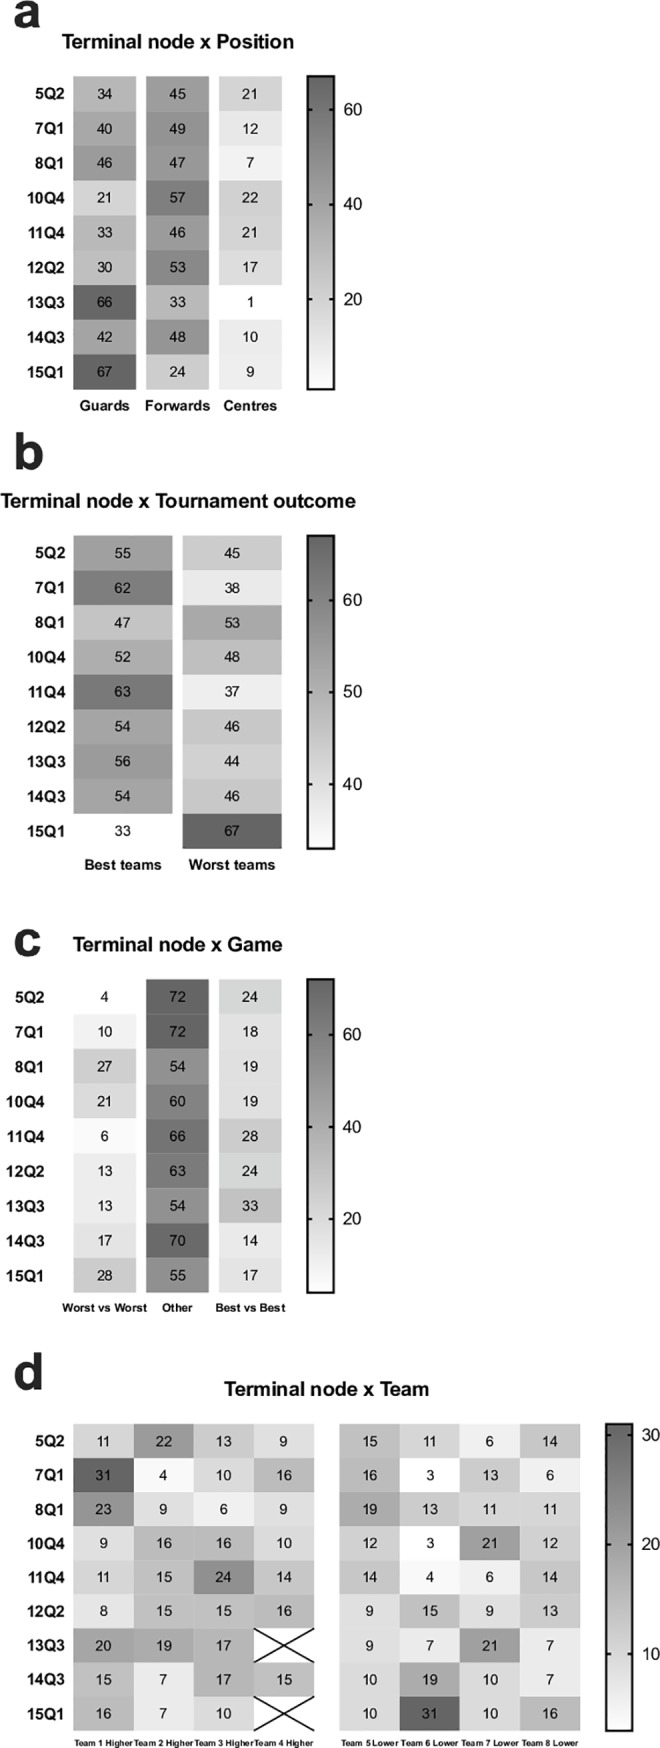
Percentages of distribution from all cases in the terminal nodes, according to playing position (panel a), tournament outcome (panel b), game (c) and team (panel d).